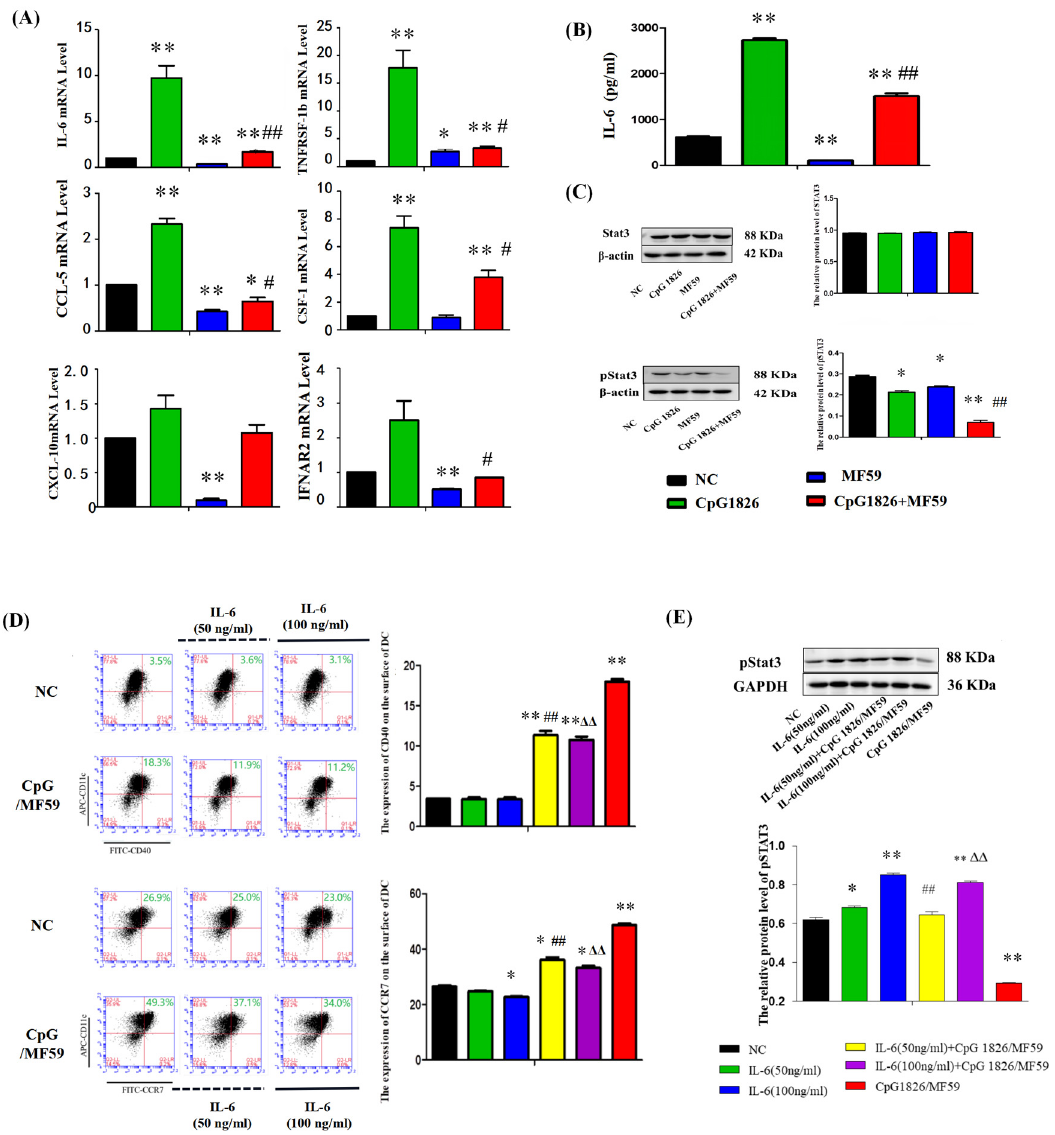
Figure 6. The MF59/CpG 1826 compound adjuvant partly promotes DC maturation by downregulating IL-6/STAT3. ( A , B ) qPCR and Western blot analysis of IL-6 mRNA and protein expression. BMDCs were stimulated with adjuvant CpG 1826 (5 µg/mL) and/or MF59 (1:400) for 48 h in vitro. The effects of CpG 1826 and MF59 on IL-6 mRNA and protein levels and other target gene mRNA levels ( A , B ), and the expression levels of STAT3 and pSTAT3 in BMDCs were analyzed by Western blotting ( C ). β -Actin was used as a control. ( D , E ) BMDCs were cultured in the absence or presence of IL-6 (50 ng/mL or 100 ng/mL) pretreatment for 3 days, and half of the liquid was replaced with IL-6 on the fifth day. On the sixth day, MF59/CpG1826 was added to the medium for another 48 h, and the concentrations of IL-4 and GM-CSF were maintained at 20 ng/mL. ( D ) The DC surface molecules CD40 and CCR7 were measured by flow cytometry. ( E ) The expression level of pSTAT3 in BMDCs treated with IL-6 was analyzed by Western blotting. GAPDH was used as a control. The relative level of pSTAT3 is expressed as the mean ± standard deviation and is shown in a bar graph. Data were derived from three independent experiments. * p < 0.05, ** p < 0.01 vs. NC group. # p < 0.05, ## p < 0.01 vs. M-M/CpG 1826 group, ∆∆ p < 0.01 vs. MF59/CpG 1826 group.